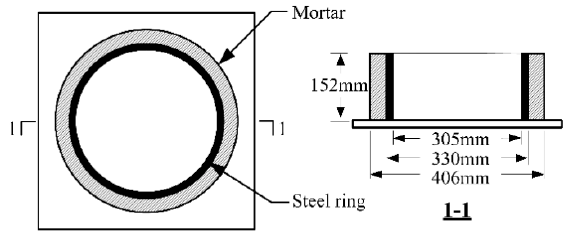
Figure 4. Test device of restrained ring shrinkage test (RRST).